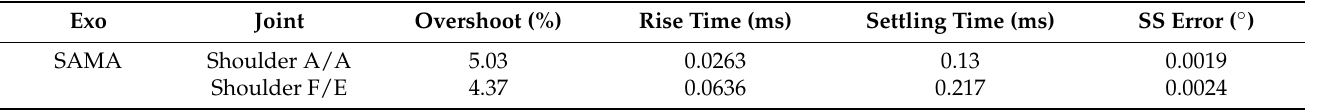
Figure 17. The dynamic model of the actuator module of the exoskeleton SAMA.